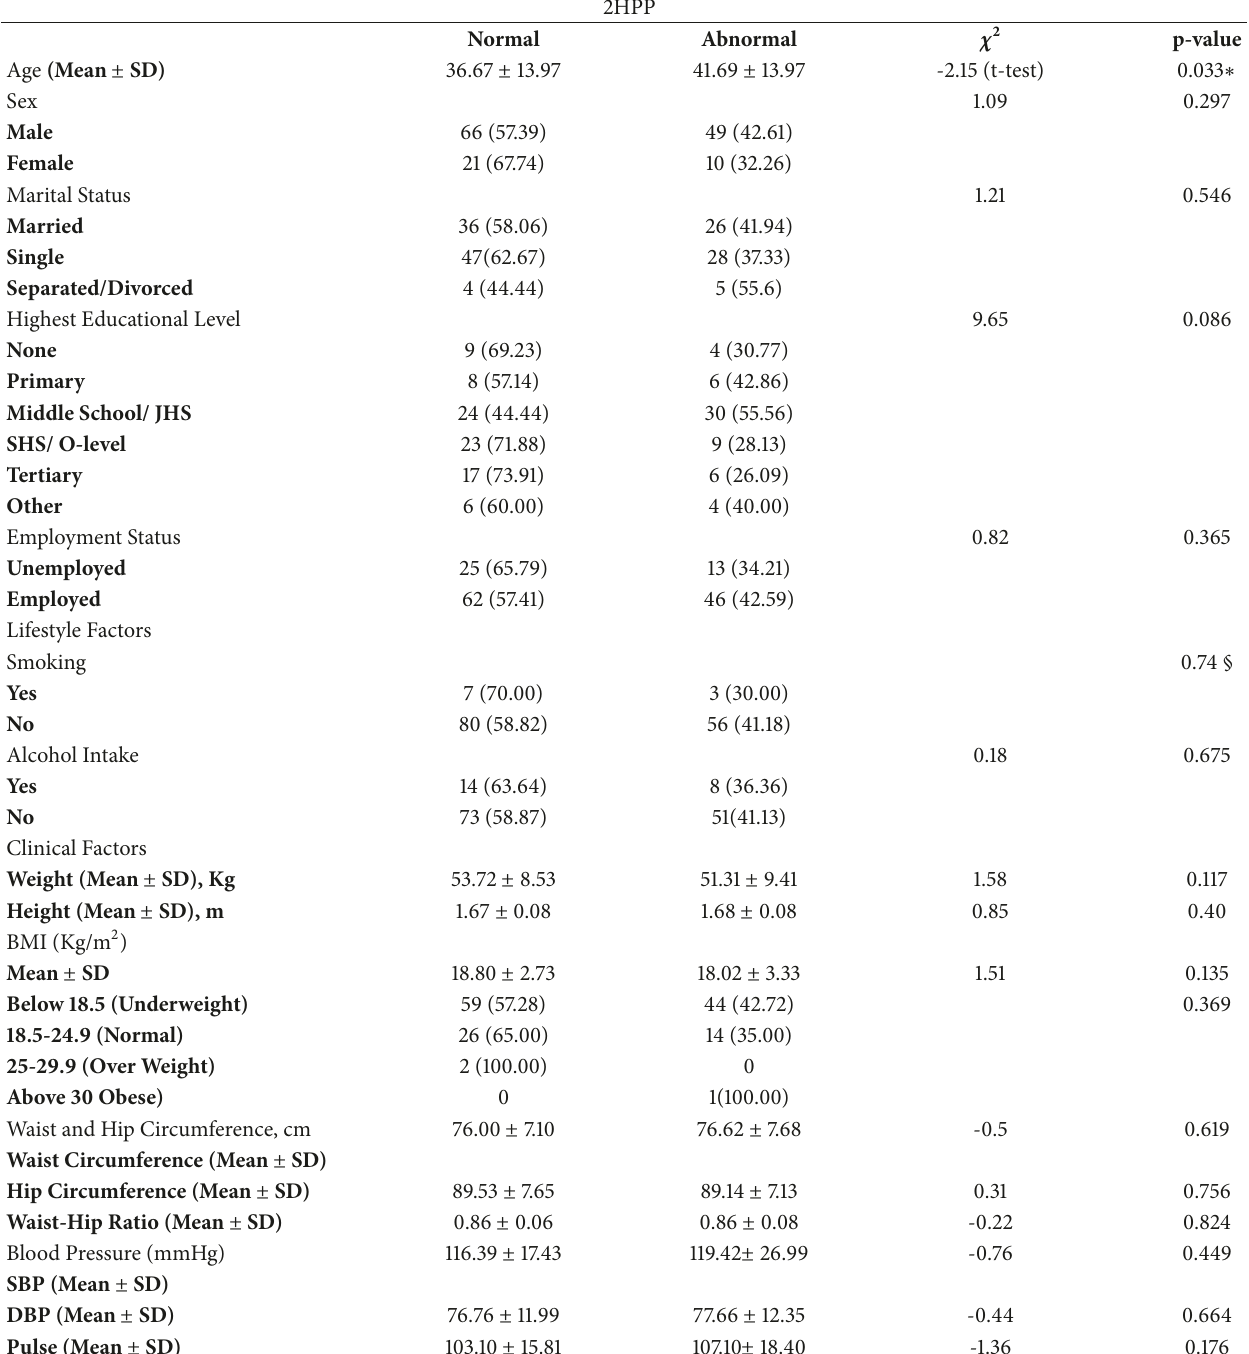
Table 2: Association between sociodemographic factors, clinical factors, and lifestyle factors and 2HPP